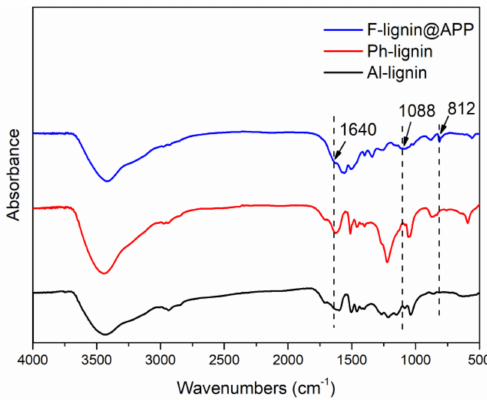
Figure 1. FTIR spectra of Al-lignin, Ph-lignin and F-lignin@APP.